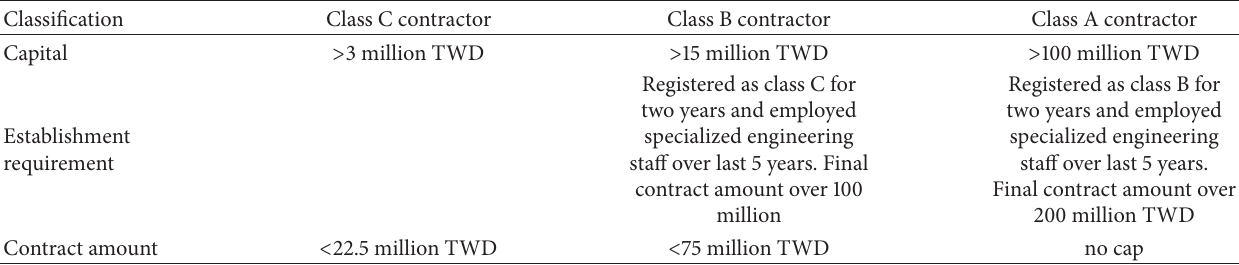
Table 1: The regulations for the management of different classes of